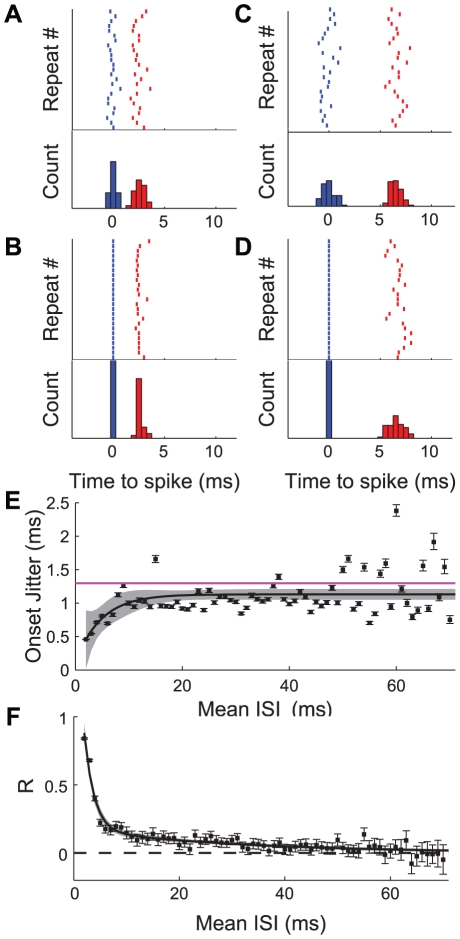
Spike-spike interactions in doublet patterns recorded in cricket interneurons.A, Upper trace: A raster plot showing 25 of 85 responses to repeated presentations of a GWN stimulus, recording from the same cell as shown in Figure 1. The cell consistently responded to the stimulus by firing a doublet (first spike shown in blue, second spike in red) with average ISI of 2.6 ms. A, Lower trace: PSTH of all 85 responses from the raster, with the color convention conserved. B, upper and lower traces: Raster plot and PSTH showing same data from A, here aligned relative to the time of the first spike in the doublet (t = 0) rather than to the timing of the stimulus. This shows the variability in ISI across presentations of a single stimulus. C and D: Data from a second doublet event (mean ISI = 6.5 ms, 73 responses) from the same interneuron, data presentation conserved. E: jitter of arrival time of first spike in repeatable doublets recorded from 40 different cells in 32 animals, as a function of ISI (7753 events composed of 197,601 total pairs of spikes). Black line shows model fit to data (Eq. 1), with shaded area representing 95% confidence envelope around predictions from the model. Horizontal purple line shows population mean of single spike jitter from frozen noise method. F: estimate of correlation coefficient between first and second spikes in repeatable doublets (from same data set as in E). Error bars represent 95% confidence limits on estimation of correlation coefficient. Solid black line shows correlation coefficient as a function of ISI modeled as a double exponential (Eq. 2), with ±95% confidence interval on predictions from the model shown by the shaded grey region.